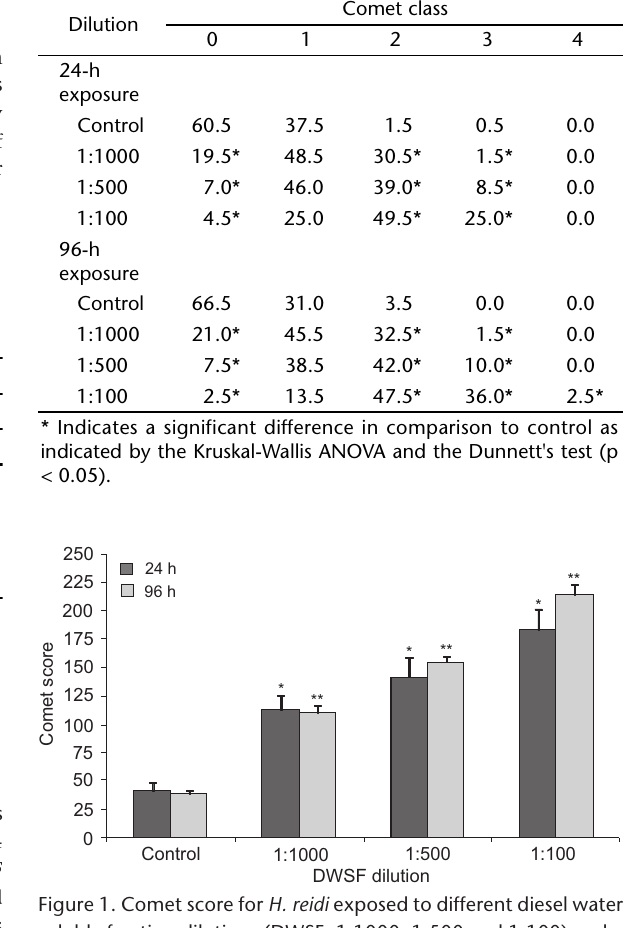
Figure 1. Comet score for H. reidi exposed to different diesel water soluble fraction dilutions (DWSF; 1:1000, 1:500 and 1:100) and a control for 24 and 96 hours. Results are expressed as mean and standard deviation. * Indicates a significant difference in compari- son to control in the 24-hours exposure period as indicated by an ANOVA and Dunnett’s test (p < 0.05). ** Indicates a significant difference in comparison to control in the 96-hours exposure pe- riod as indicated by an ANOVA and Dunnett’s test (p < 0.05).